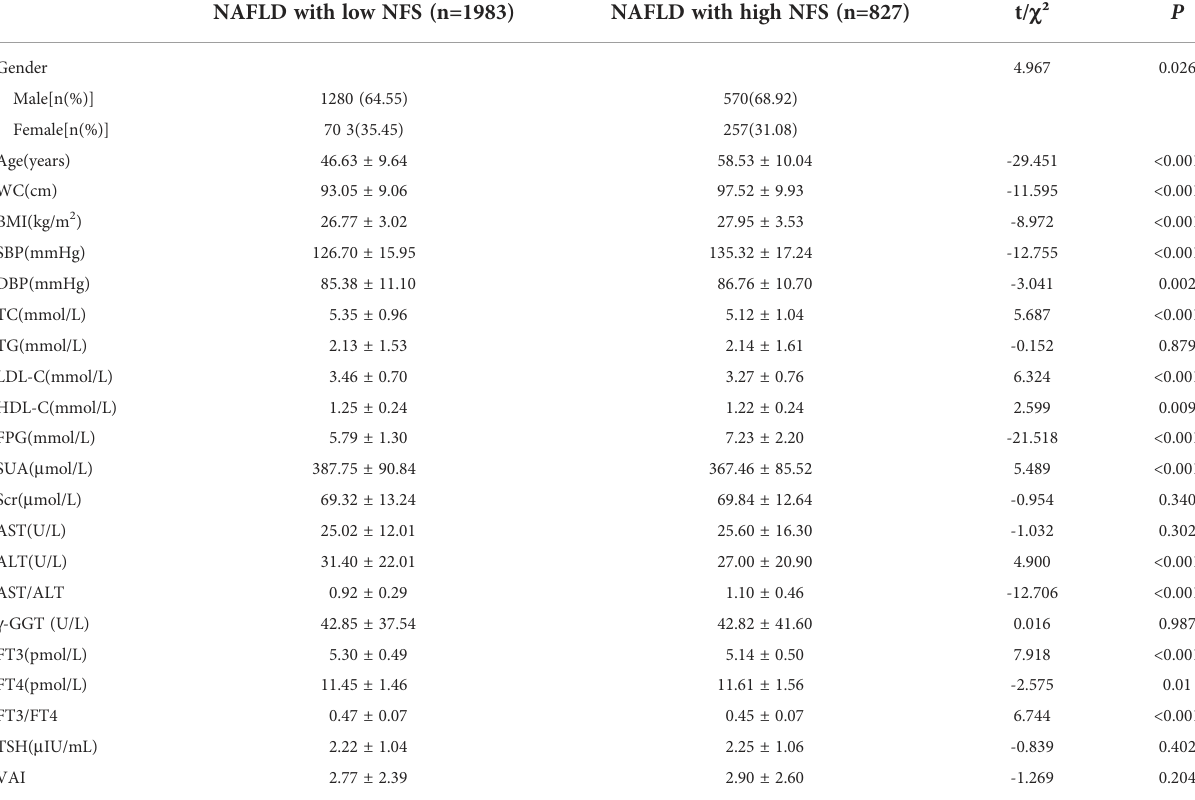
TABLE 3 Comparison of basic demographic characteristics of NAFLD positive subjects with low NFS and high